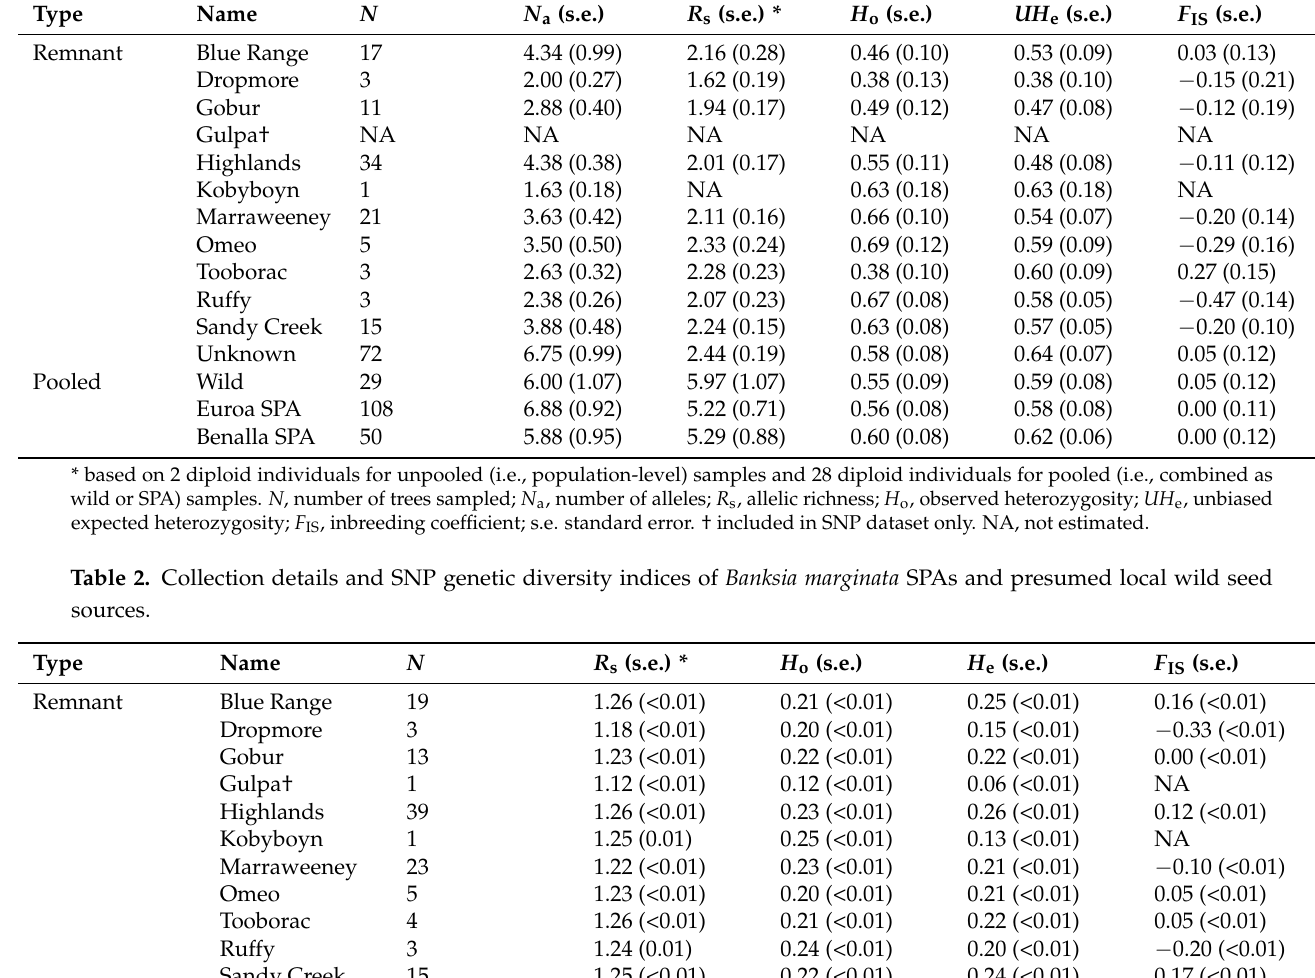
Table 1. Collection details and SSR genetic diversity indices of Banksia marginata SPAs and presumed local wild seed sources. Type